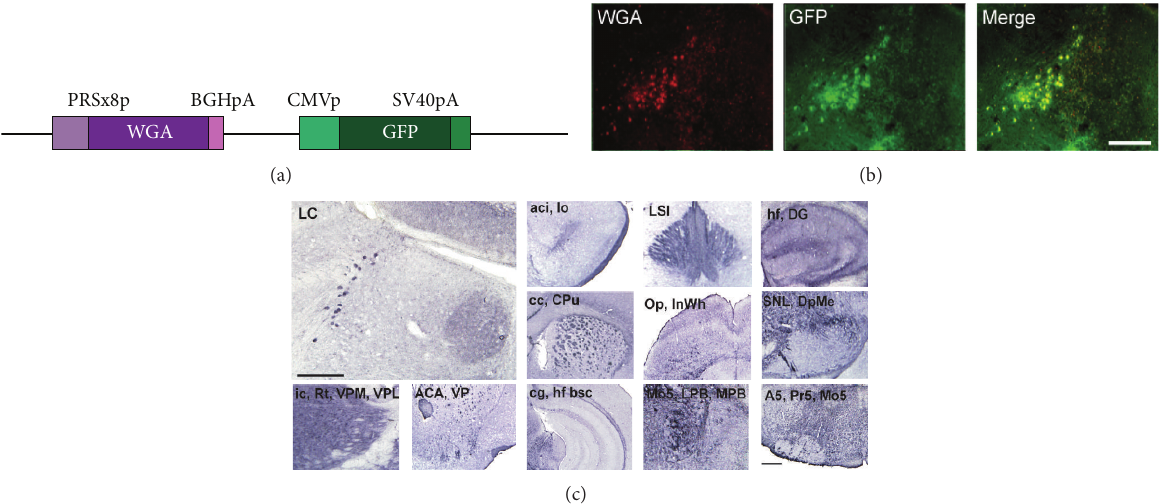
Figure 1: Expression of WGA and GFP in LC, detecting PRS-WGA adenovirus. (a) Schematic diagram representing the structure of the transgene. (b) WGA immunoreactivity in the noninjured mouse brain. After 2 days of PRS-WGA adenovirus injection in the LC, LC- originated WGA protein was detected in NA neurons and other areas. Scale bars = 500 𝜇